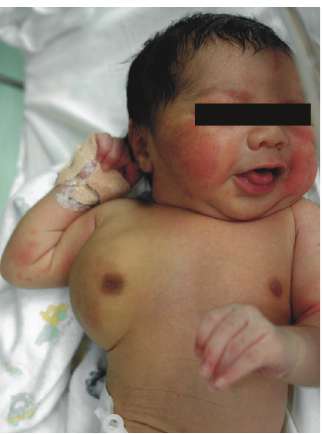
Figure 7: Picture showing right chest swelling shortly after birth.